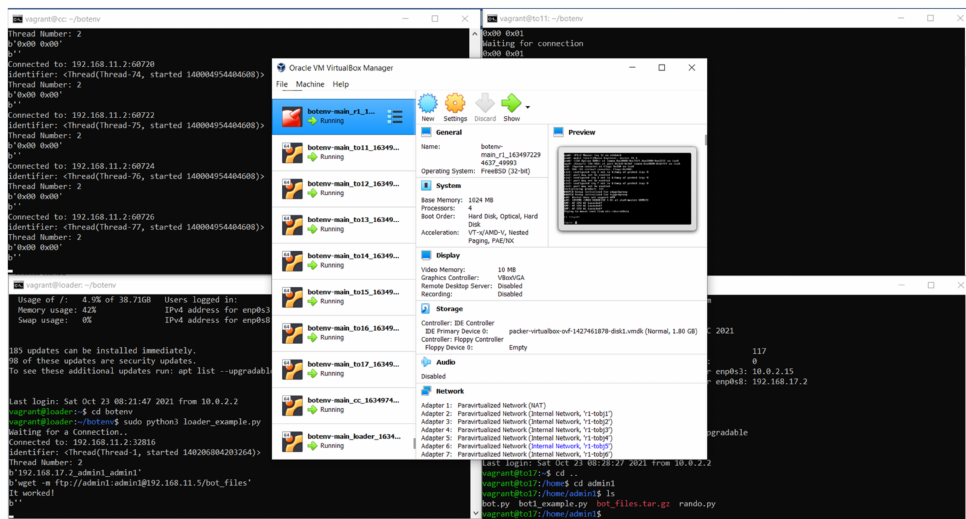
Figure 6. The deployed testbed environment.